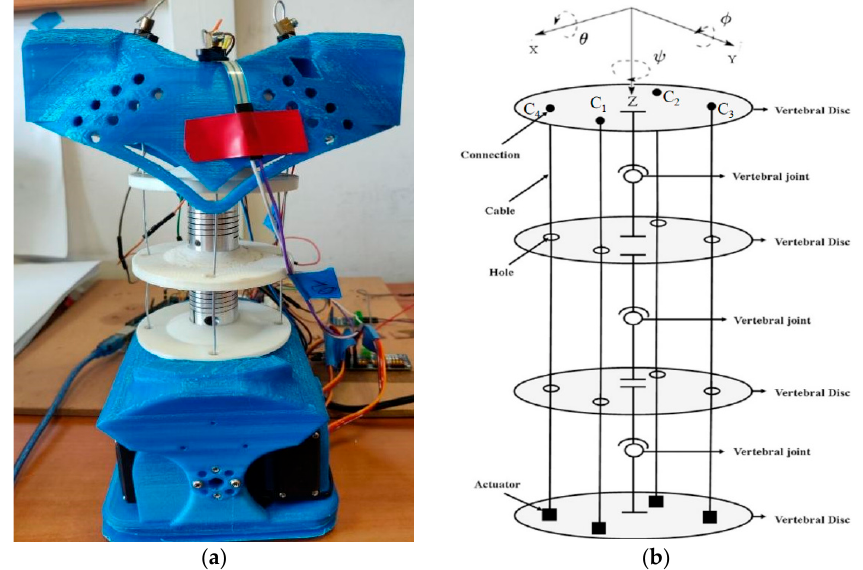
Figure 4. LARMbot torso V1 at LARM2 laboratory in Rome: ( a ) a prototype; ( b ) a scheme [23].